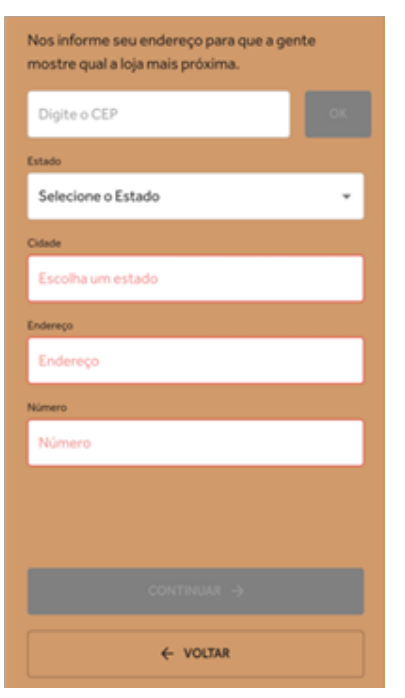
Figure 4. Entry page for other location